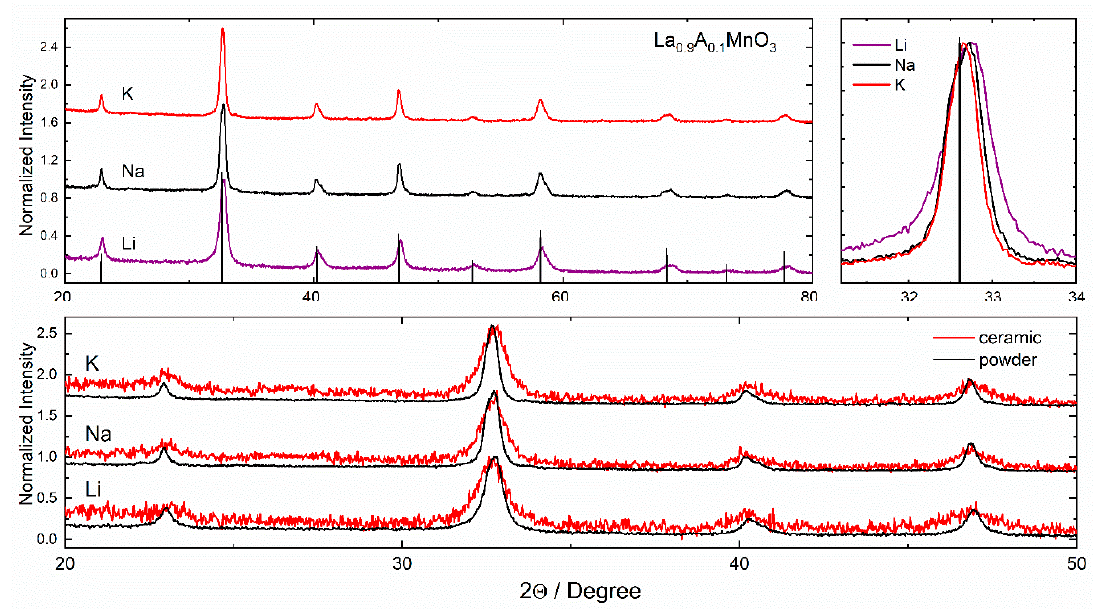
Figure 1. XRD patterns measured for La 0.9 A 0.1 MnO 3 powders and Figure 1 . XRD patterns measured for La 0.9 A 0.1 MnO 3 powders and ceramics.